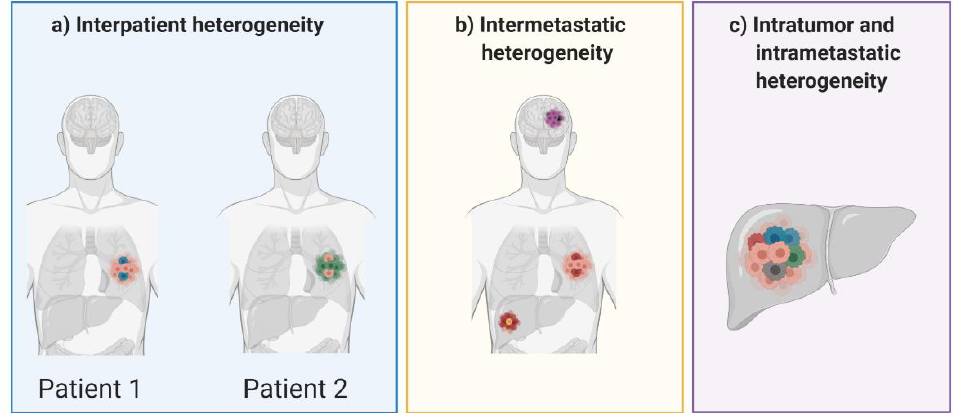
Figure 2. Forms of tumor heterogeneity that can occur between patients and in individual